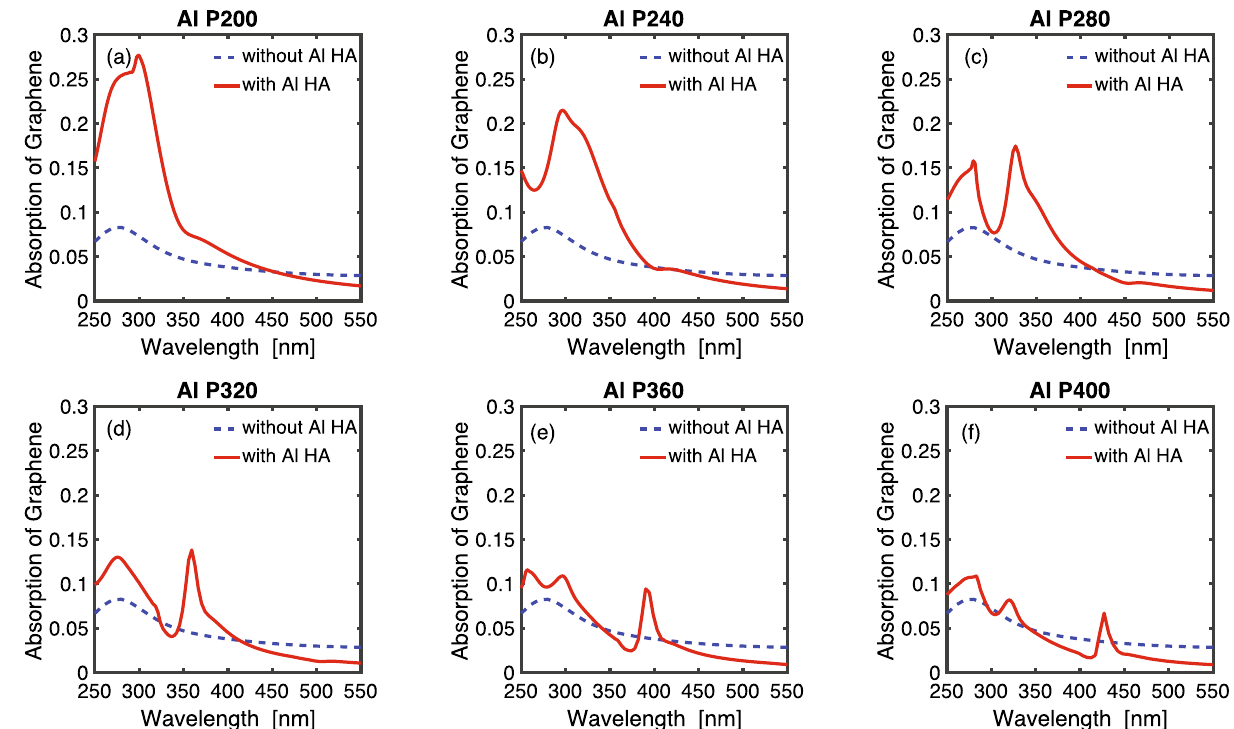
Figure 3. Graphene absorption spectrum on an aluminum hole-array. The periodicities of the aluminum hole- array are ( a ) 200 nm ( b ) 240 nm ( c ) 280 nm ( d ) 320 nm ( e ) 360 nm ( f ) 400 nm. The solid red line represents the absorption in graphene on an aluminum hole-array. The dashed blue line represents the absorption in an intrinsic monolayer of graphene without